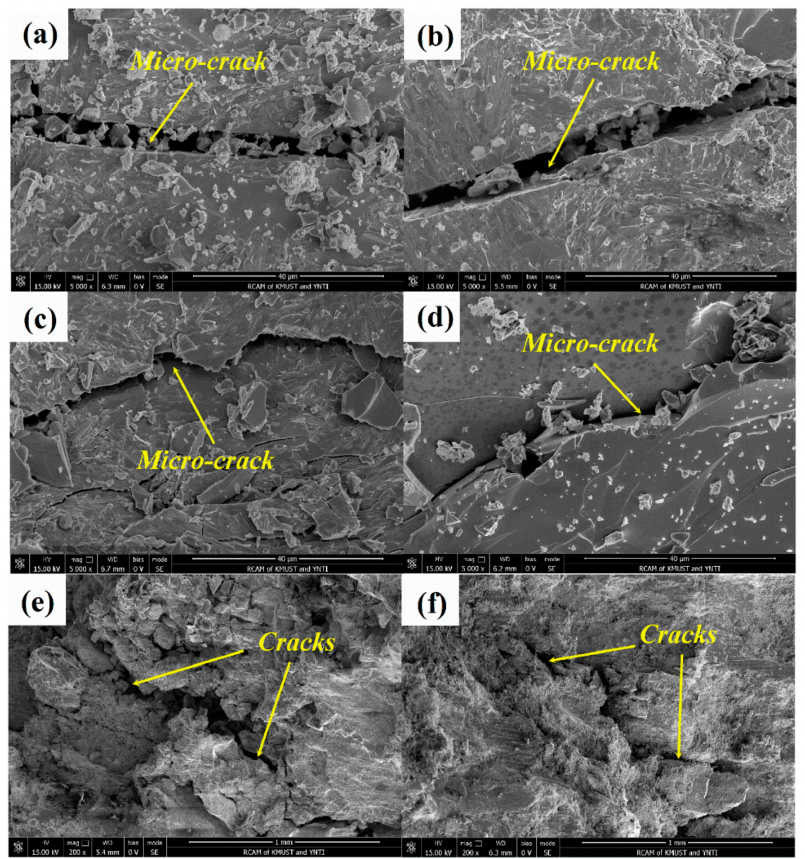
Figure 6. The fracture morphology of WC p /iron matrix composites with different particle shape: ( a , c , e ) spherical particle; ( b , d , f ) irregular particle.